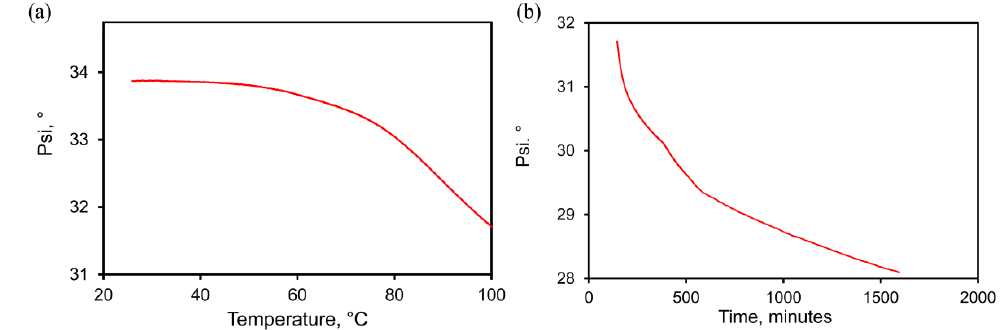
Figure 4. Change in optical ψ value of sample as a proxy for its density, determined during in situ heating in an ellipsometer. Sample was deposited at ~300 °C with ~65% Al and was de-alloyed in 0.1 M NaOH for 2 min. ( a ) During ramp to 100 °C; ( b ) During isothermal heat treatment at 100 °C.